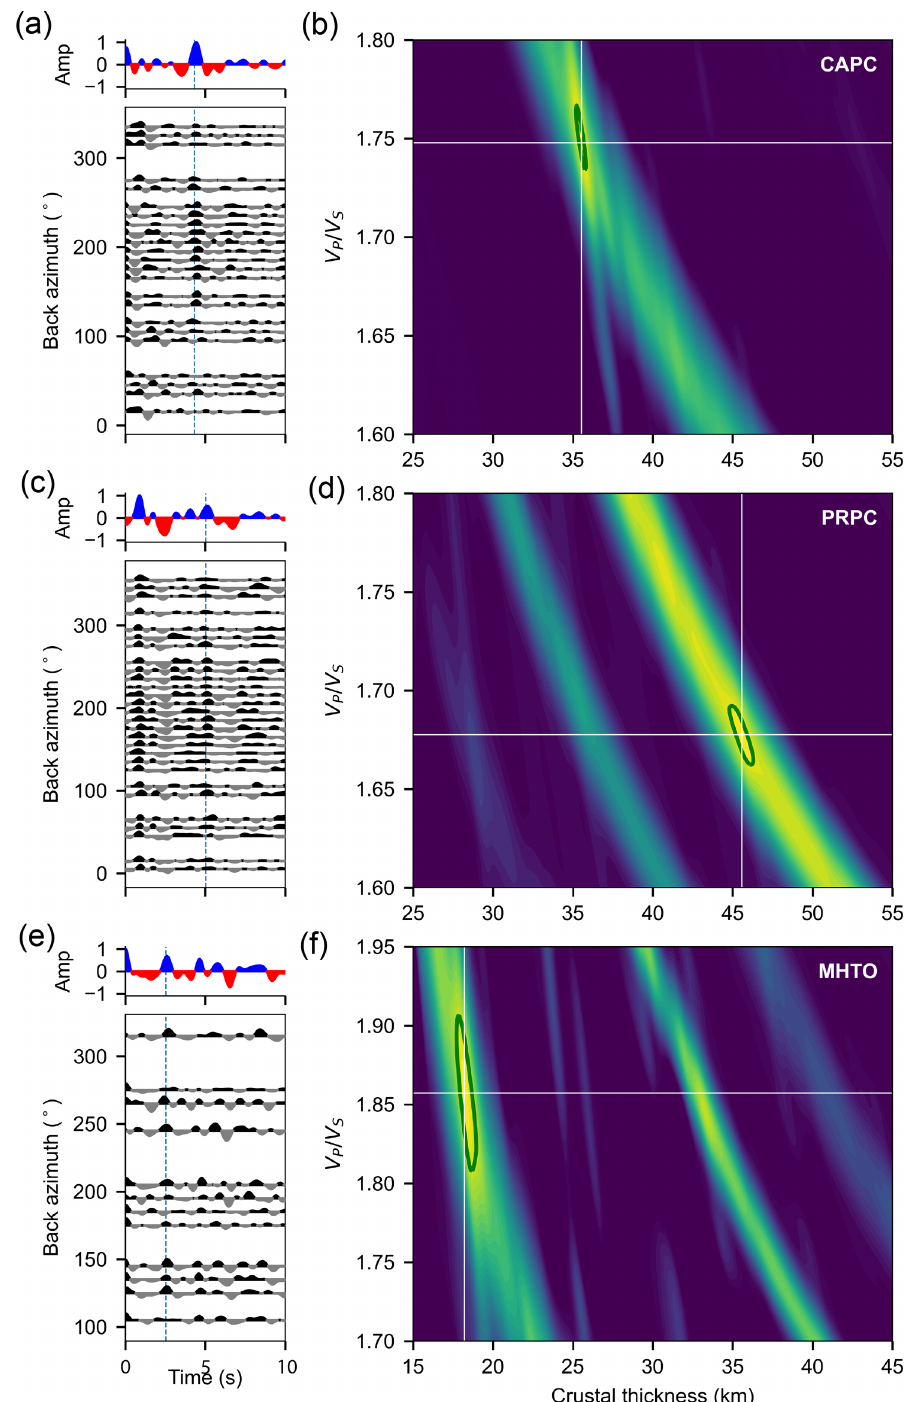
Figure 8. H-k and receiver function estimation for CAPC, STPC and PRCPC stations. (a, c, e) RFs of teleseismic earthquakes (black and white) used to obtain the RFs stack (blue and red). (b, d, f) H-k maps highlighting the maximum power corresponding to the optimal crustal